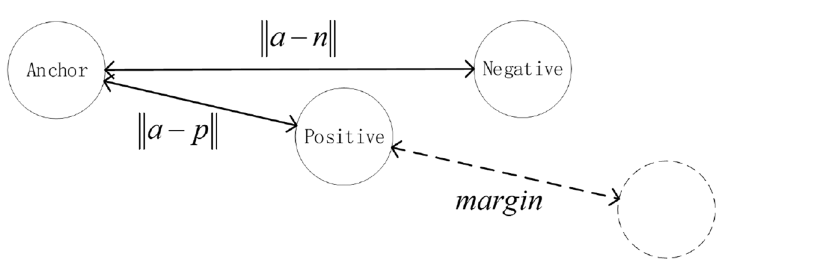
Figure 6. Semi-hard